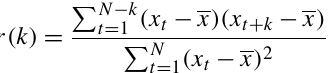
Figure 8. Glider Hovmöller diagram for O 2 (a) and p CO 2 (b) surface-averaged data (0–20m) with SeaCycler data removed for the period 3 October–22 November 2016. Dots indicate the location of data samples. The location of K1 and SeaCycler (SC) moorings is shown in